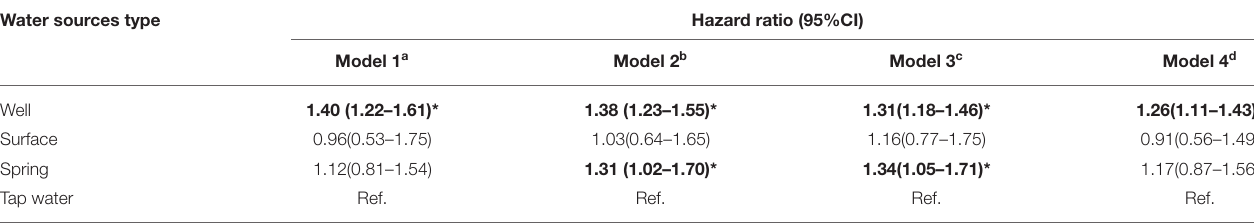
TABLE 4 | Sensitivity analyses for the association between the water source and